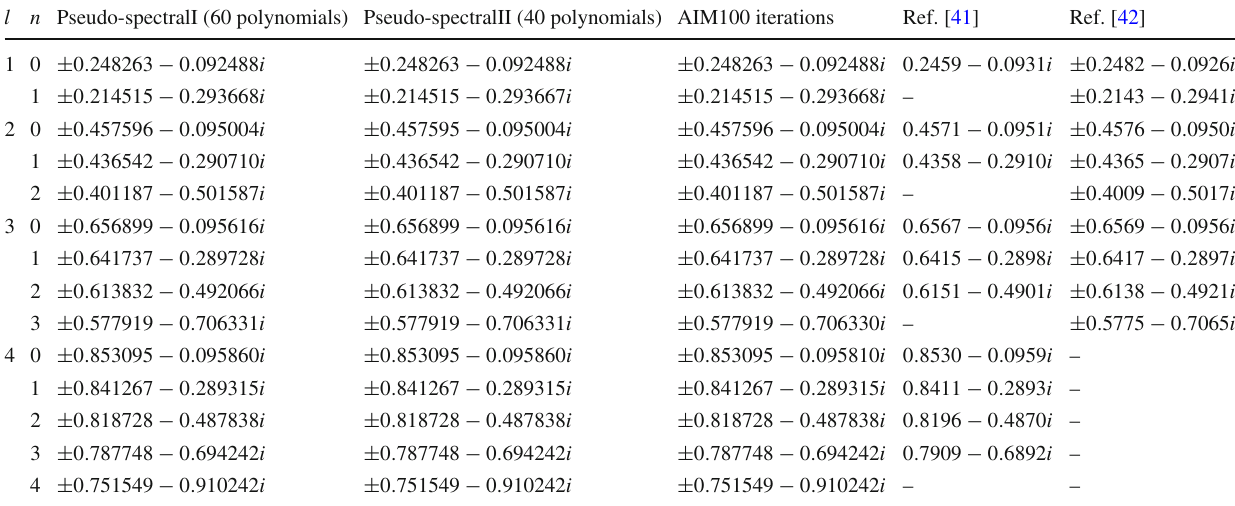
Table 2 Quasinormal frequencies of the spin 1 perturbations normalized by the mass ( M ω) compared against the results of Refs. [41,42] l n Pseudo-spectralI (60 polynomials) Pseudo-spectralII (40 polynomials) AIM100